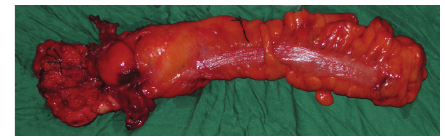
Figure 3: Abdominoperineal resection specimen.